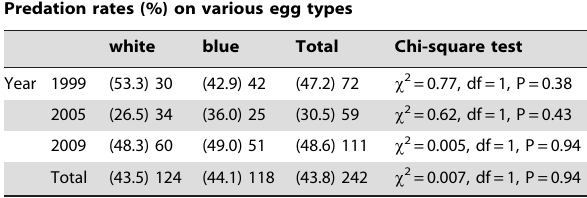
Table 3. Occurrence of nest predation in ashy-throated parrotbills.